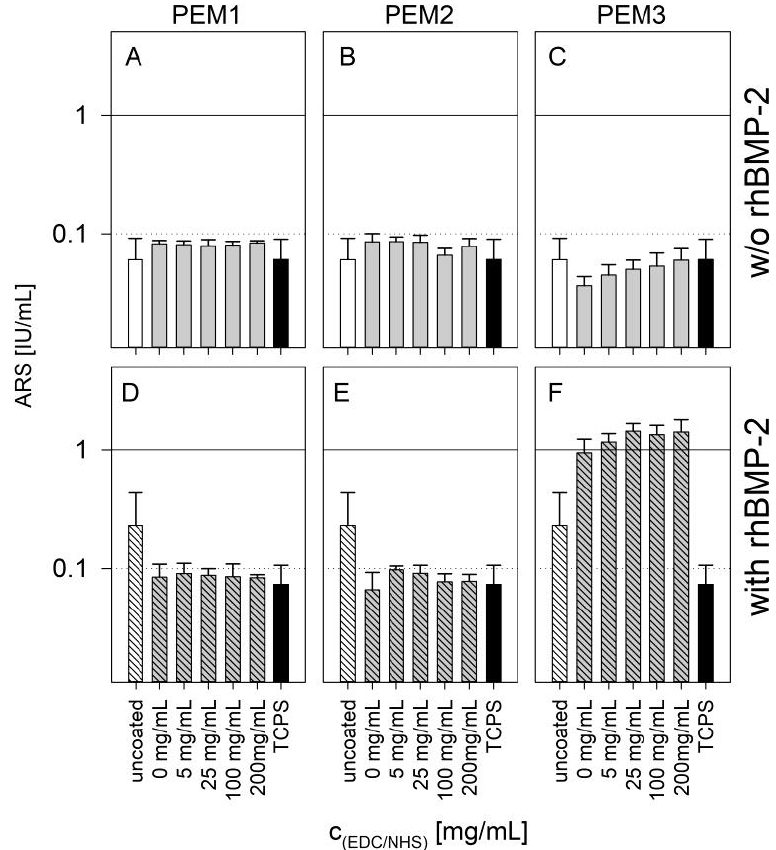
Figure 6. Absorbance of ARS assay on different cross-linked PEMs unloaded ( A – C ) or loaded with BMP-2 ( D – F ) after 21 days of cultivation in logarithmic scale. Error bars represent standard